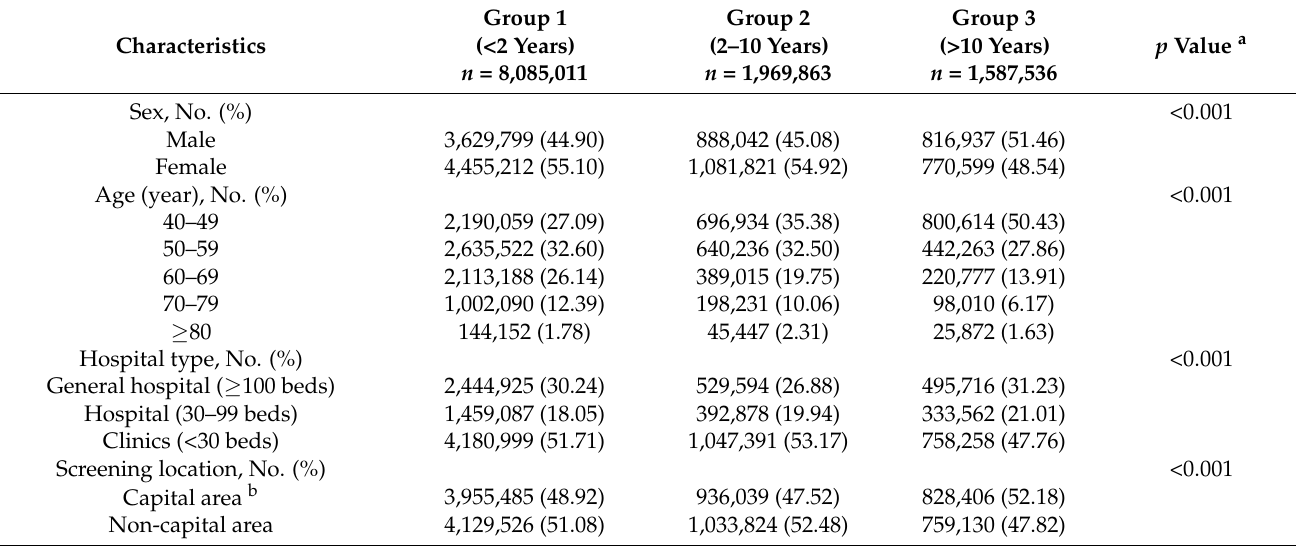
Figure 1. Flow diagram for selection of enrolled participants in this study. Among the participants from the first cycle (9,892,812, 2013–2014), 6,726,191 (67.99%) were re-screened in the next cycle of 2015–2016, and 3,137,875 (31.72%) did not return for screening. In the second cycle, 4,916,219 were newcomers who did not participate in the previous cycle. KNCSP, Korean National Cancer Screening Program. * Participants who received negative results but were diagnosed with ulcer were confirmed subsequent gastric cancer diagnosis within eight weeks. Table 1. Sociodemographics of the screening participants and characteristics of screenings based on participation interval for screening